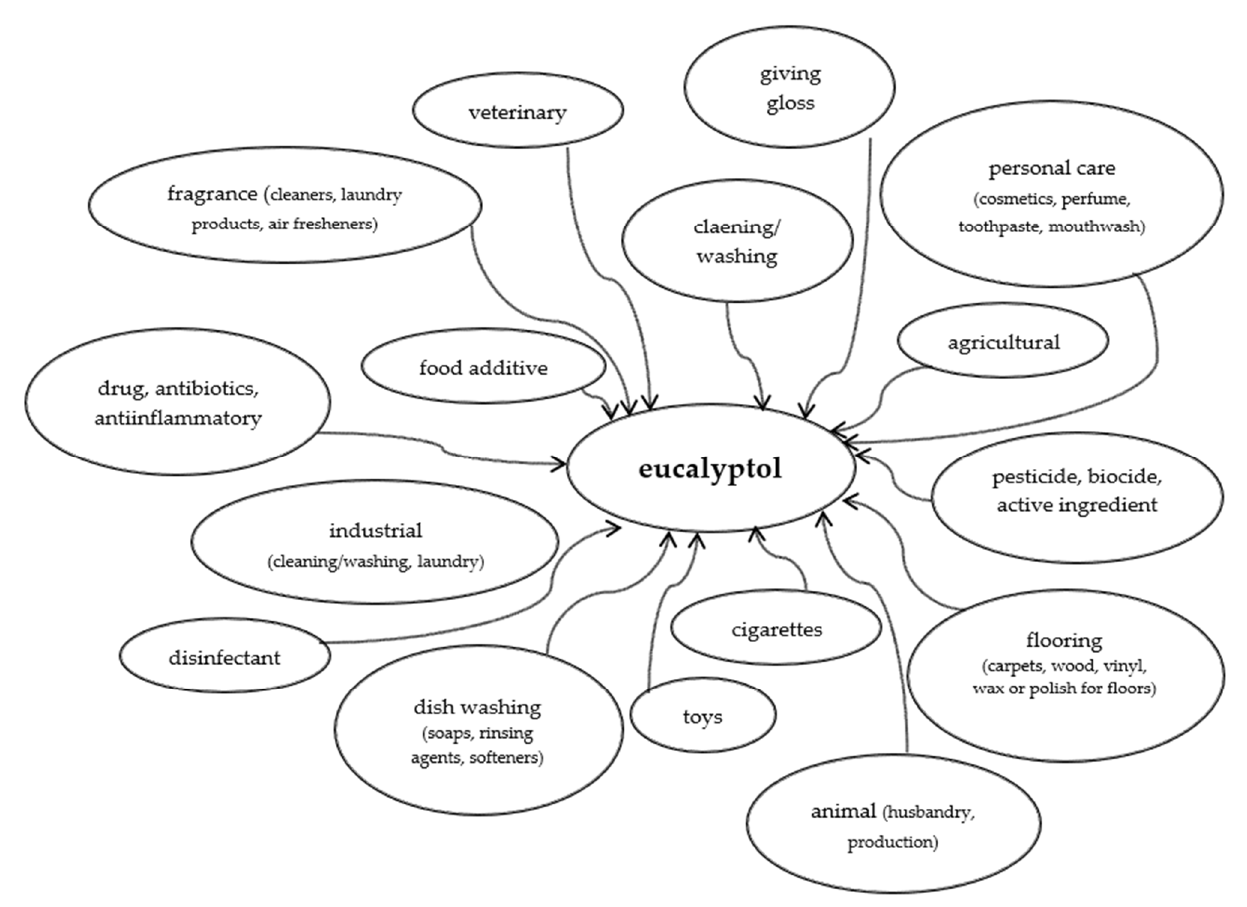
Figure 3. Spheres of wide use of eucalyptol (based on [106]).